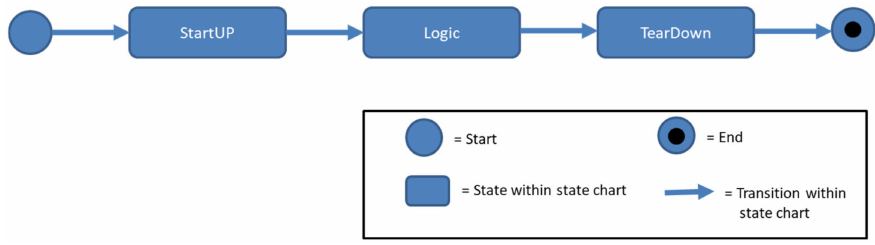
Figure 7. Basic Structure of a test case in